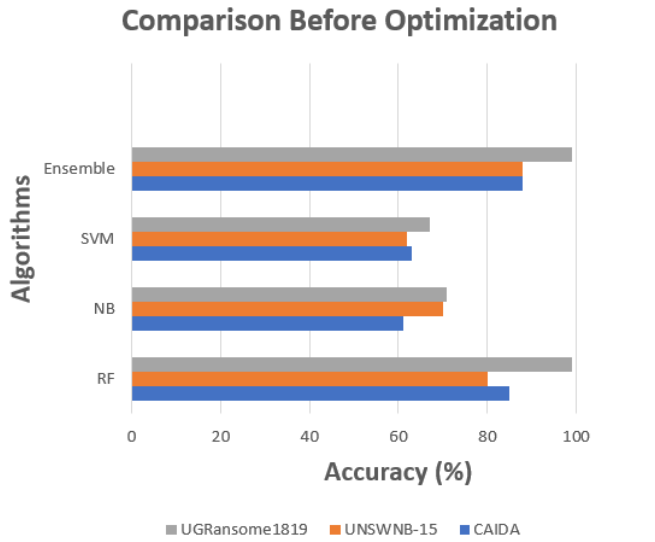
Figure 20. Comparing the UGRansome1819’s Accuracy to existing datasets (before